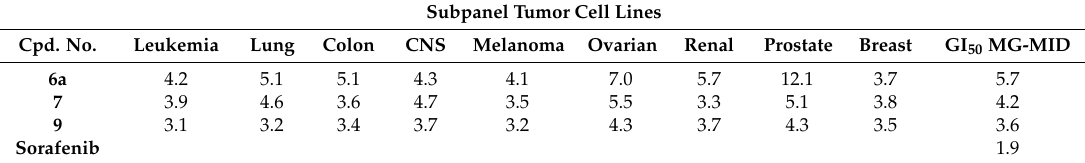
Table 5. Median growth inhibitory concentrations (GI 50 , µ M) of in vitro subpanel tumor cell lines and GI 50 ( µ M) full panel mean-graph mid-points (MG-MID) of compounds 6a , 7 and 9 in comparison with sorafenib.